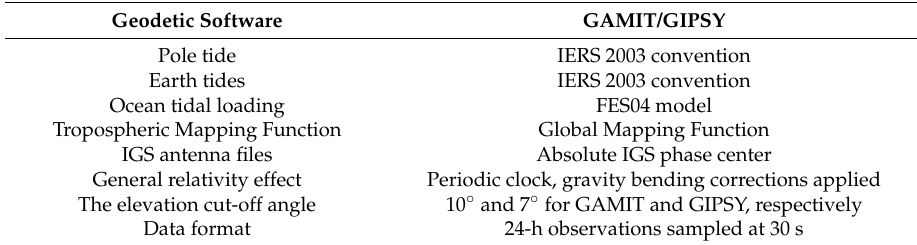
Table 1. Strategies and geophysical models applied when processing GPS time series with GAMIT and GIPSY.